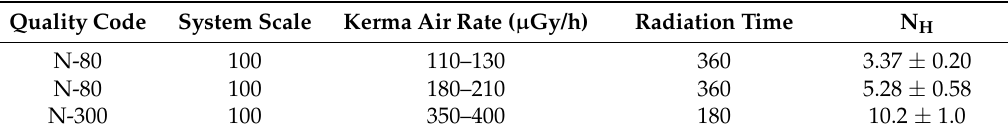
Table 7. Verification results for our